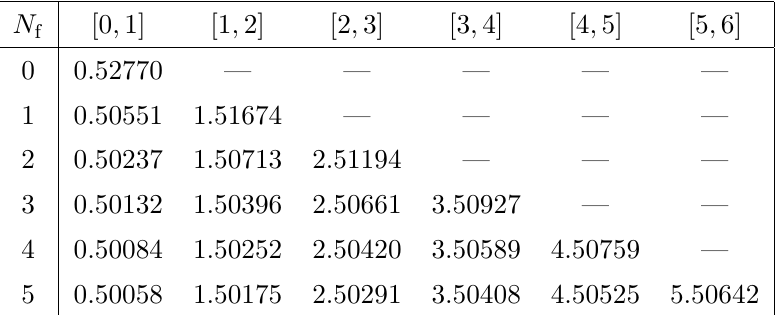
Table 1 . Location of (cid:12)rst-order phase transitions in each interval of k for the Dyson index (cid:12) = 2 and the choice (cid:11) 2 = 1, in particular we have chosen eq. (2.5) for the \Chern-Simons" coupling (cid:11) 2 . e The critical point in the interval [ N f ; N f + 1] is obtained by solving (2.35) for N f + " with " ! 0. This equation has a unique real solution, because the right hand side plus 2 (cid:21) monotonically increasing. The unique solution